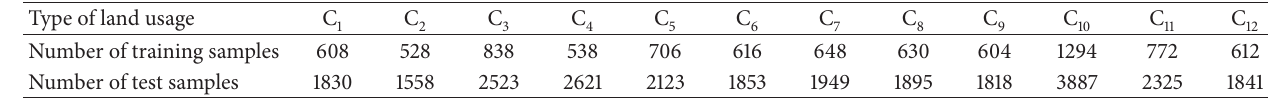
Table 1: All the samples extracted from the first zone.